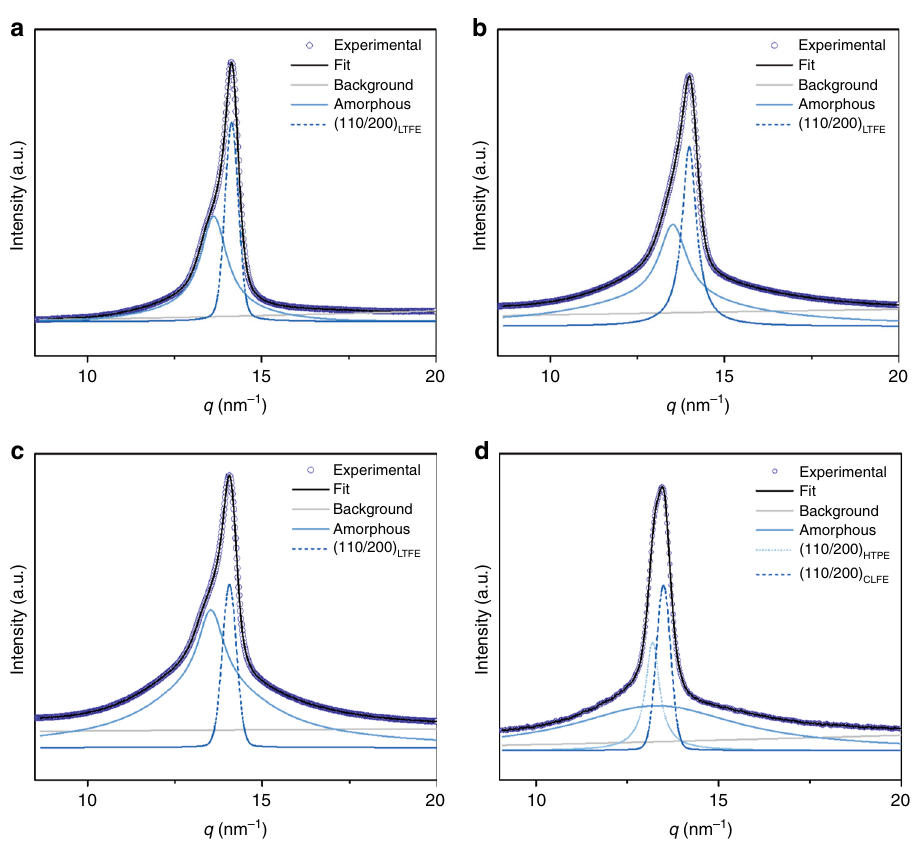
Fig. 4 Crystalline phase of P(VDF-TrFE). WAXS pro fi les of a P(VDF 70 -TrFE 30 ), b P2VP- b -P(VDF 70 -TrFE 30 )- b -P2VP, c PS- b -P(VDF 70 -TrFE 30 )- b -PS, d P2VP- b -P(VDF 50 -TrFE 50 )- b -P2VP. Peak fi tting is performed to determine the crystalline phases and overall crystallinity of the polymer samples. The experimental pro fi les were deconvoluted by using the sum of a linear background, and few pseudo-Voigt peaks describing the scattering from the amorphous and the different crystalline phases. For WAXS pro fi le of pristine P(VDF 50 -TrFE 50 ) see Supplementary Fig. in the case of P2VP- b -P(VDF 50 -TrFE 50 )- b -P2VP in which lower crystallinity is obtained after integrating the DSC thermogram. The reason of this mismatch is that the Δ H 100 used for the calculations of crystallinity are dependent on the TrFE content and are therefore not known exactly. This causes the deviation from the values obtained using WAXS, that can be considered as the more accurate method.